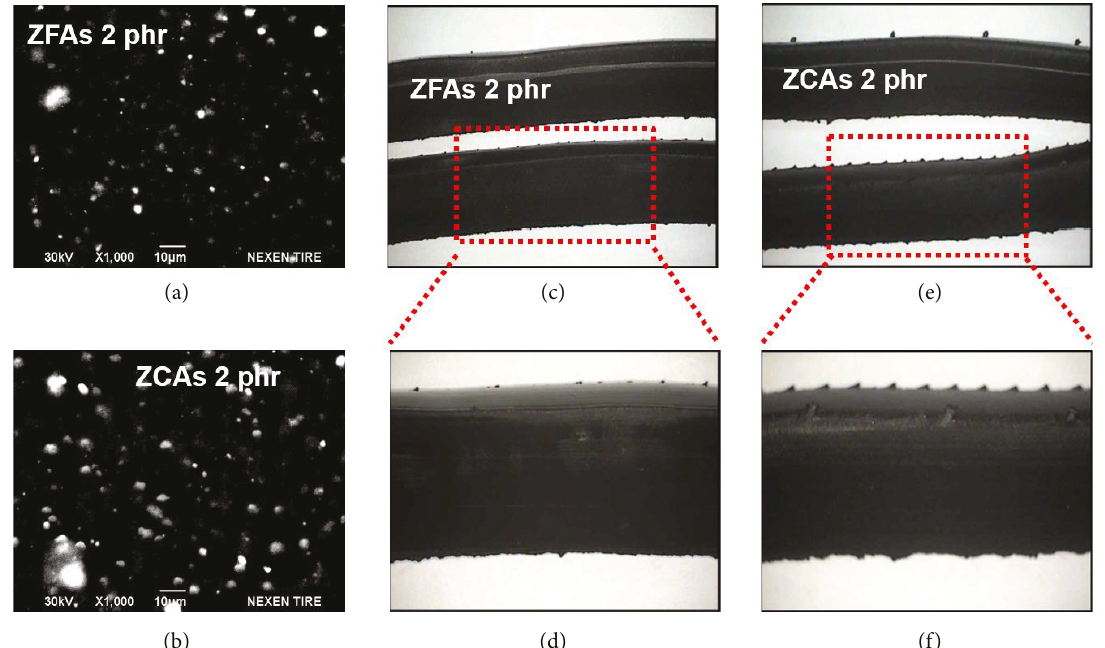
Figure 3: Scanning electron microscopy (SEM) micrograph of rubber composites made with (a) ZFAs and (b) ZCAs. (c) Images of Garvey die extrusions of rubber composites made with (c) ZFAs (enlarged image in (d)) and (e) ZCAs (enlarged image in